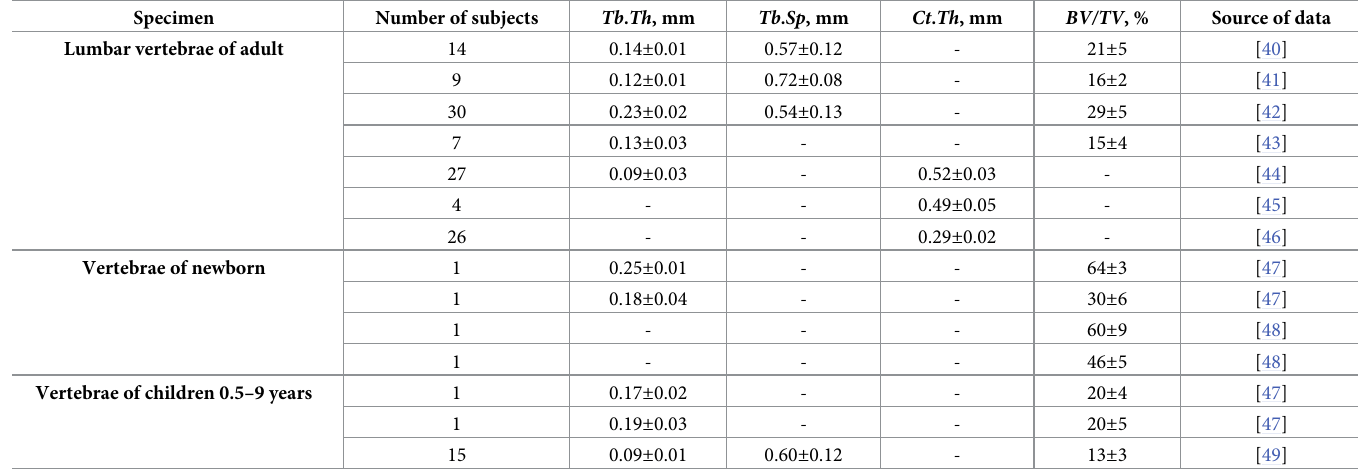
Table 2. Examples of morphometric parameters estimated in different studies for the vertebrae of adults, children, and newborns (means and standard deviations). Specimen